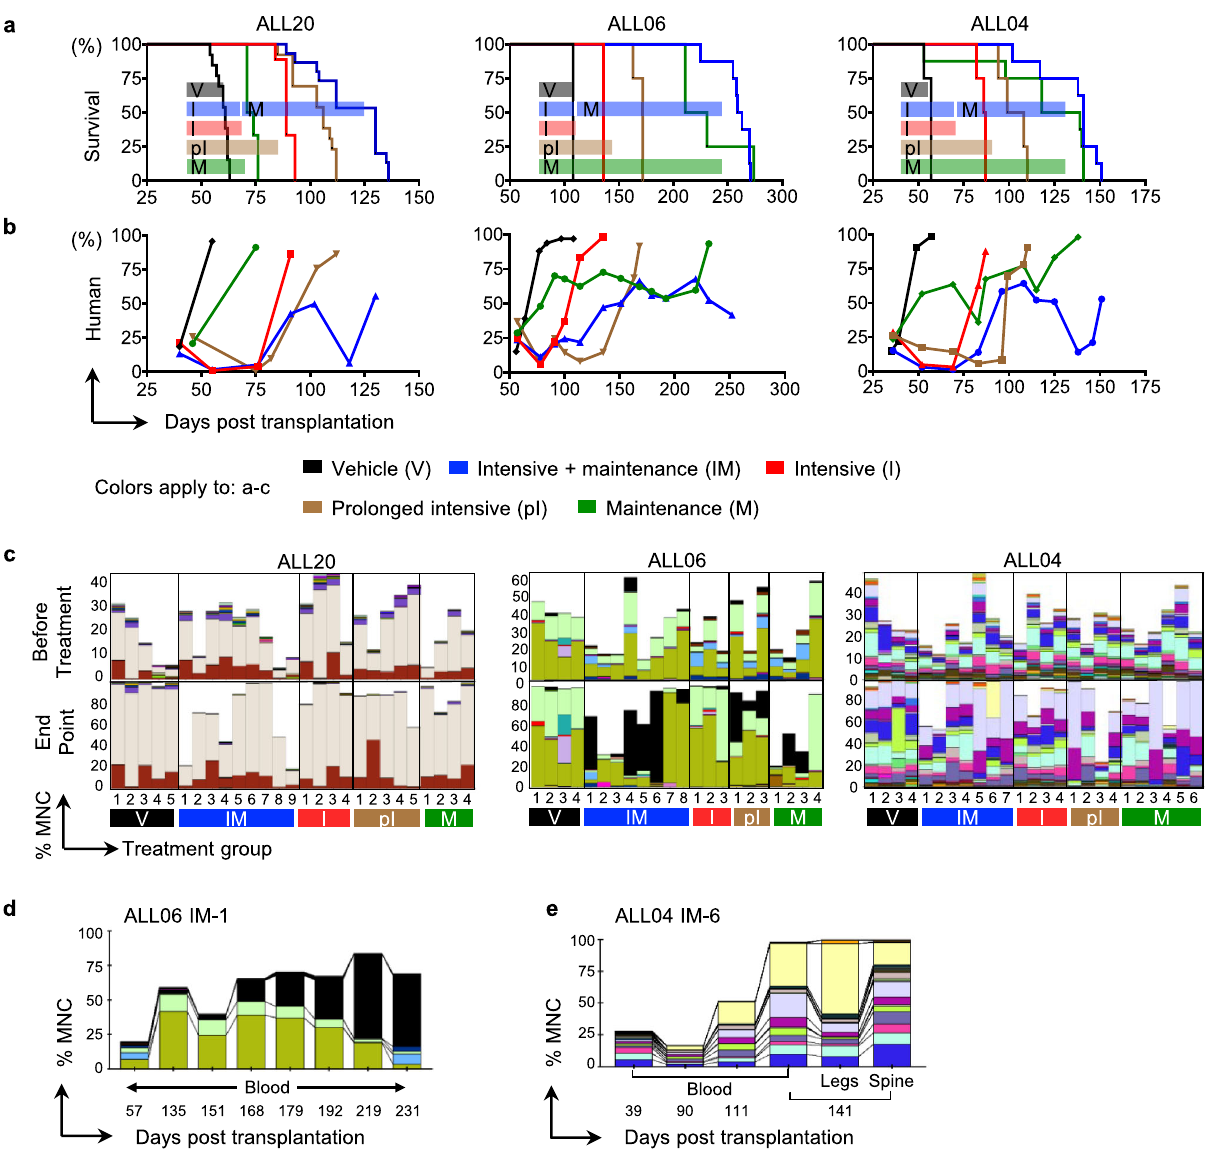
Fig. 4 Comparing the same leukemia clones during different chemotherapy treatments across multiple mice. a Kaplan – Meier survival plots of PDX mice under various treatments. Color bars illustrate the duration of the treatment for each group. b Human chimerism in the peripheral blood. Shown are the means of all experimental mice. Mouse variations are provided in Supplementary Fig. 16. c Clonal abundance in mouse blood before treatments and at the end time point for each mouse. Each column represents one mouse. Each color represents one distinct genetic barcode corresponding to a leukemia clone. d , e Representative clonal dynamics during combination therapy in two PDX mice. Additional mice are shown in Supplementary Figs. 17 – 19. The black-colored clone in multiple mice of ( c , d ) and Supplementary Fig. 18 represents non-barcoded (GFP − ) human cells from patient ALL06. PCR analysis reveals that these GFP − human cells did not carry any genetic barcode (Supplementary Fig. 20). They may have originated from a clone that had lost the barcode construct or that may have been collected due to a sorting error. These non-barcoded human cells were not detected in mice that received the vehicle treatment or short intensive therapy, or in any mice that received sorted GFP + B-ALL cells derived from the other patient samples. Source data are provided as a Source Data fi